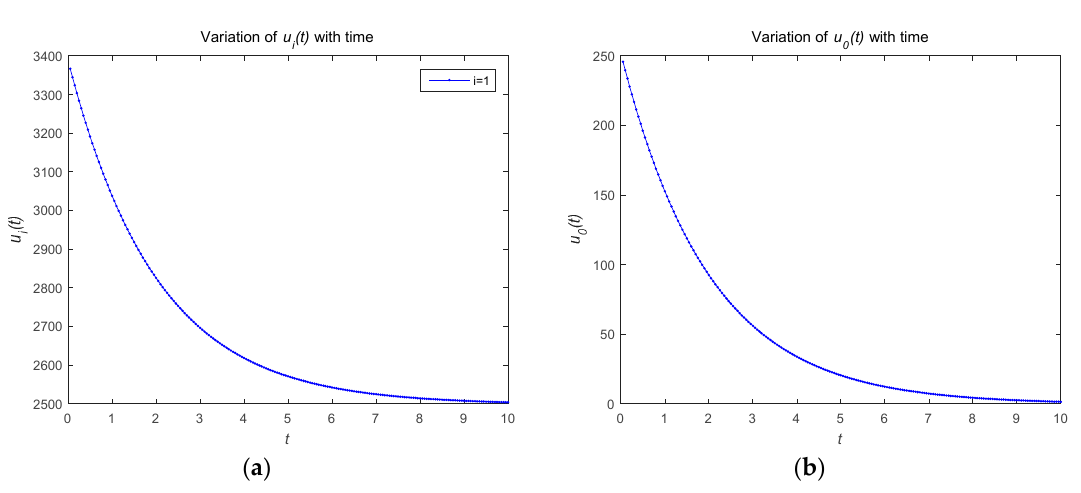
Figure 1. ( a ) Optimal strategy of the attackers; ( b ) optimal strategy of the defender.